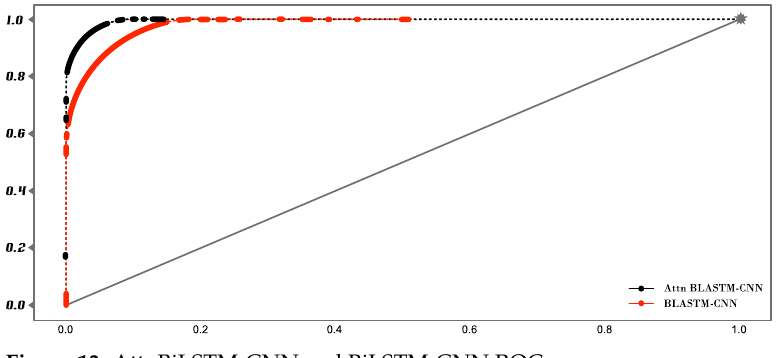
Figure 13. AttnBiLSTM-CNN and BiLSTM-CNN ROC curves.